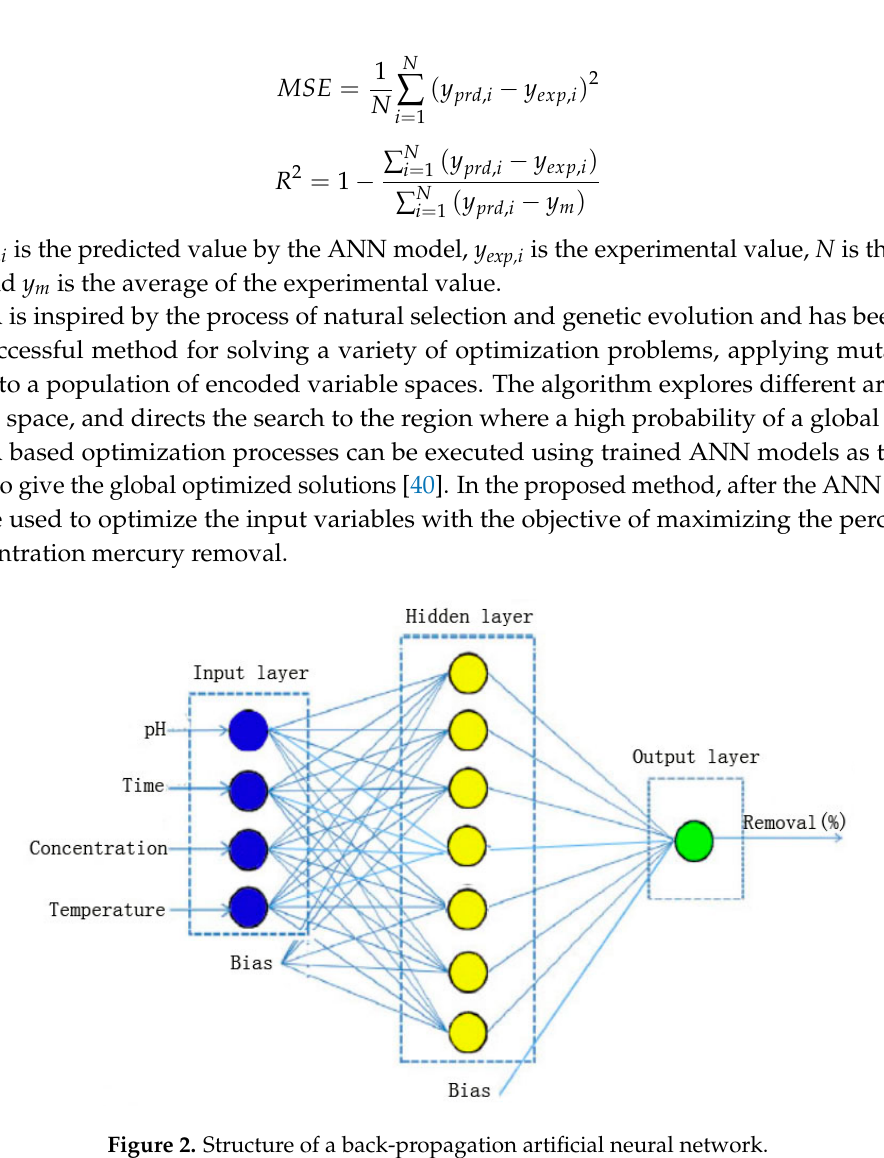
Figure 2. Structure of a back-propagation artificial neural network.